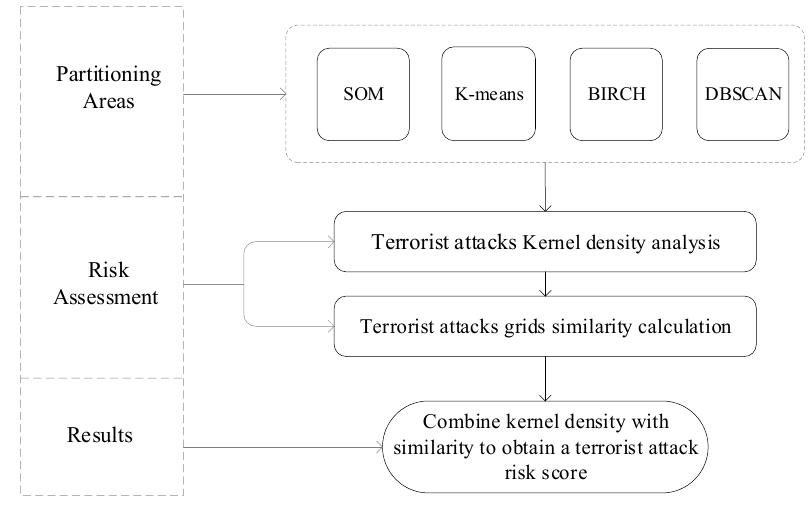
Figure 3. Evaluation flow chart.